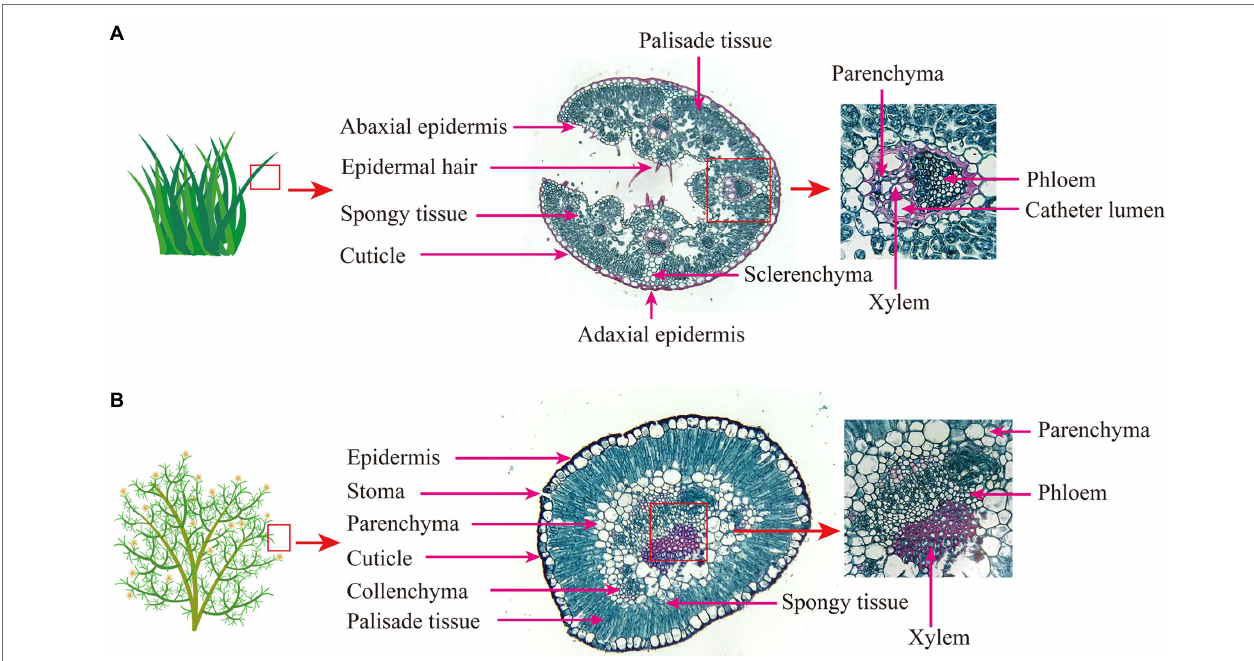
FIGURE 3 | Light microscopy images of the leaf transverse profile for (A) S. glareosa and (B) P. harmala under control (N0) treatment. The images were taken under a magnification of 10× (left) and 40×